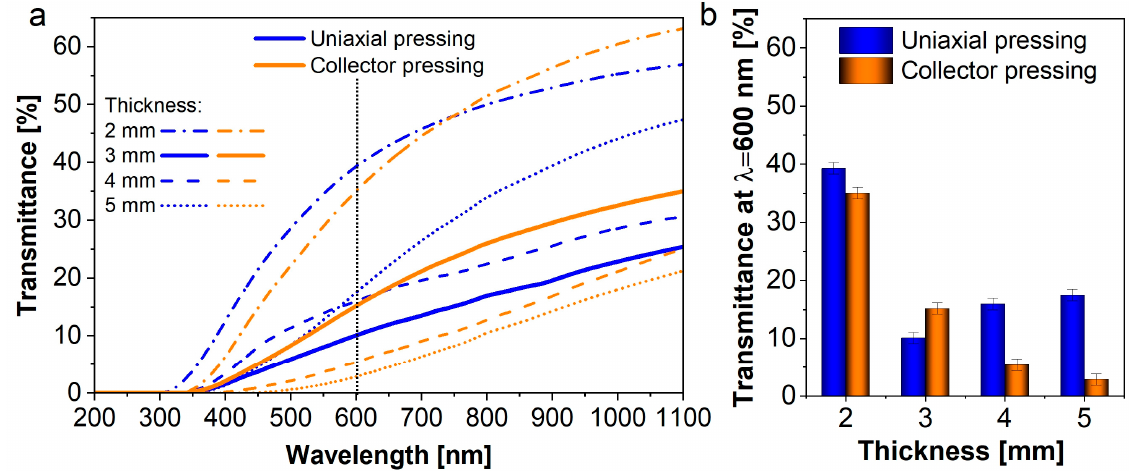
Figure 5. Diffuse transmission spectra ( a ) and transmission coefficient value at λ = 600 nm ( b ) of YSZ